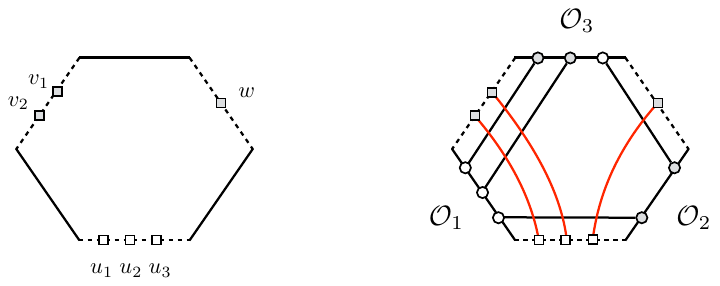
Figure 2 . Hexagon form factor with magnons on the mirror edges and its (cid:12)shnet counterpart. The quartic interactions are pushed to the boundary and absorbed inside the bridge factors. The hexagon form factor captures the splitting of the magnons’ wave function according to the pattern of free (red)